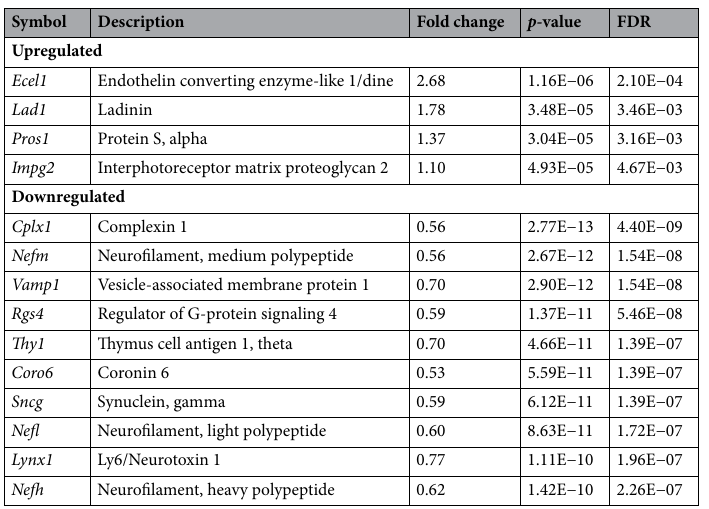
Table 3. Most highly up- or downregulated retinal transcripts in bTBI- vs. sham-treated mice at 5-weeks post injury detected by RNA sequencing. FDR false discovery rate.